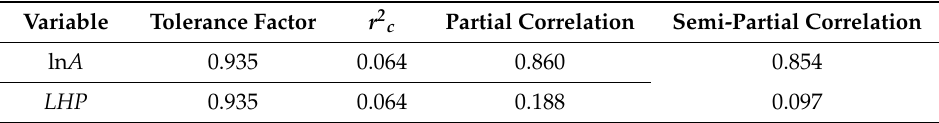
Table 4. Results of the collinearity analysis of independent variables in the studied forms of the model for determining Q MED in the mountain catchments of the Upper Vistula